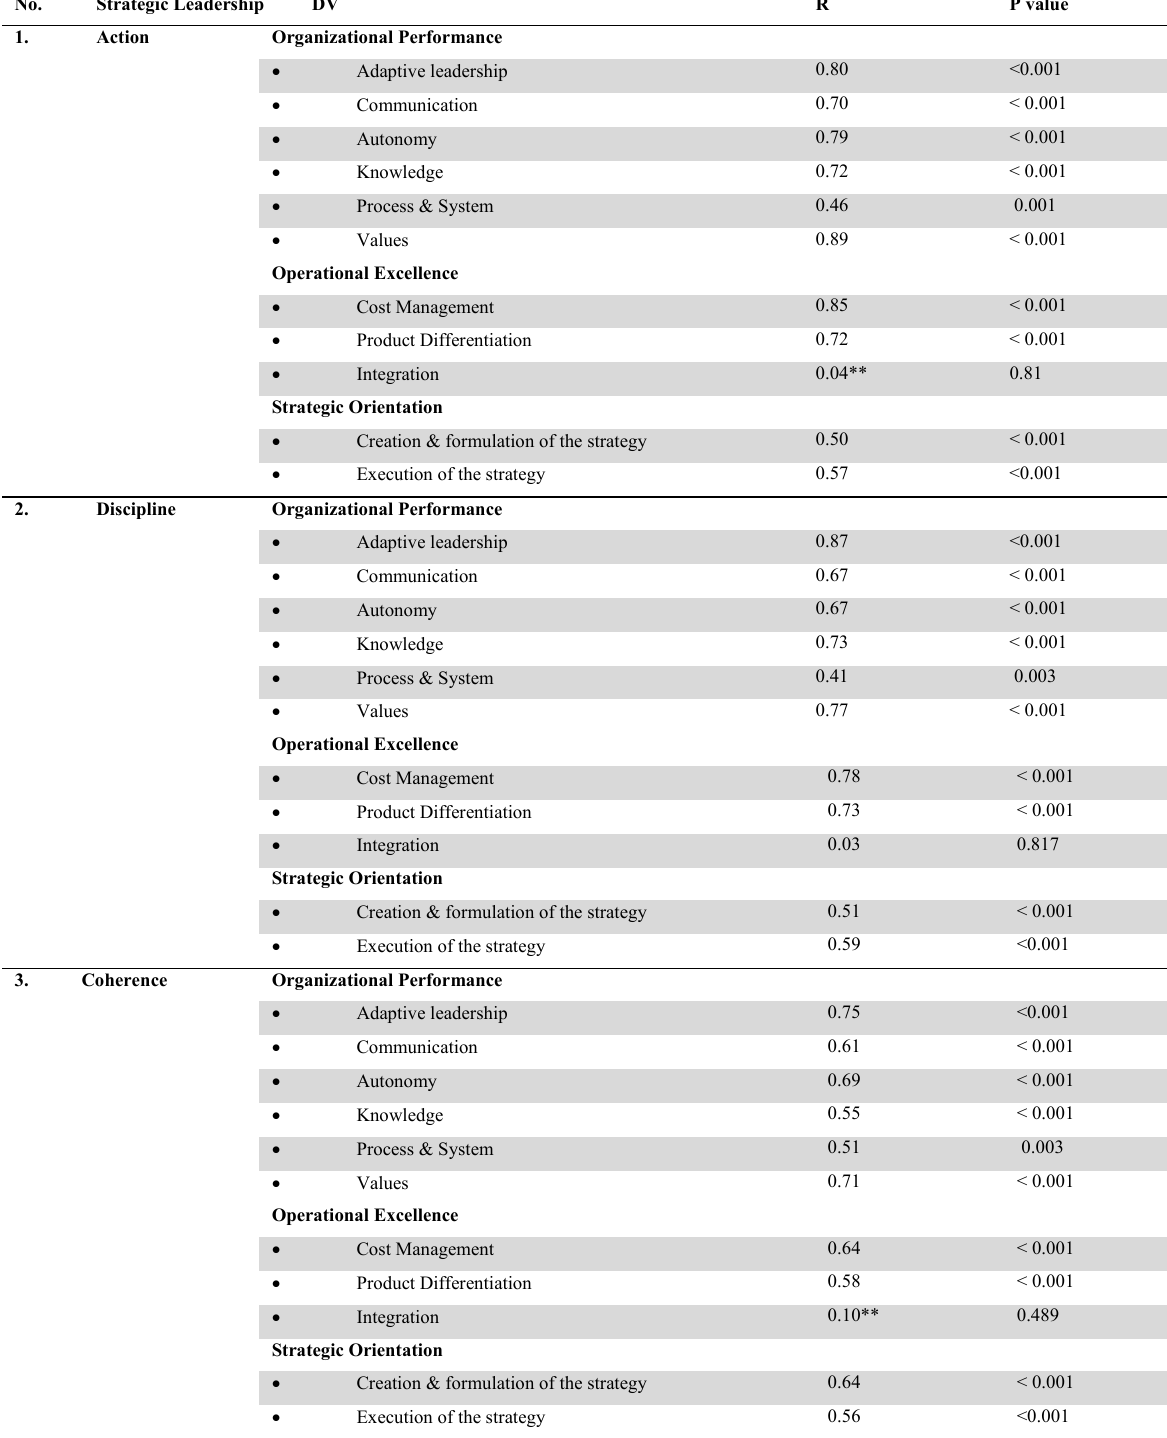
A summary of the correlation of strategic leadership on the operational strategy, organizational perfor- mance and strategic orientation in PROTON (n=48)